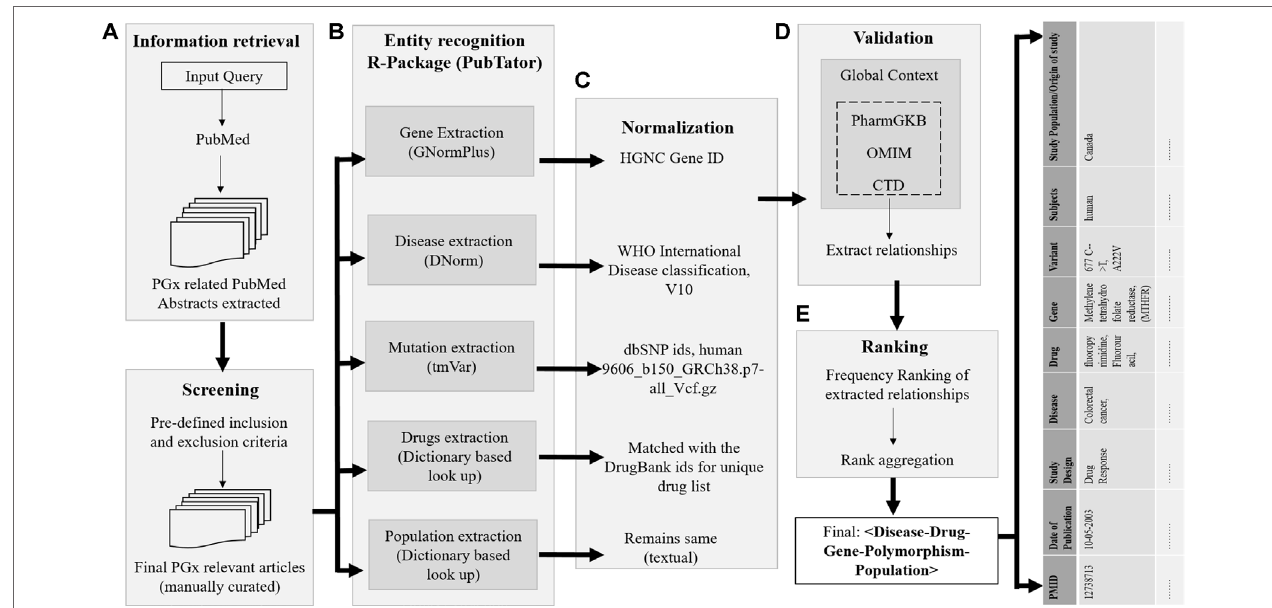
FIGURE 1 | Overview of the proposed approach. The process of retrieving evidence-based sentences from PubMed abstracts using pubmed.mineR includes: (A) information retrieval, (B) entity recognition, (C) normalization, (D) validation, and (E) data integration and ranking. The final list of relationships of disease–drug– gene–polymorphism is tabulated